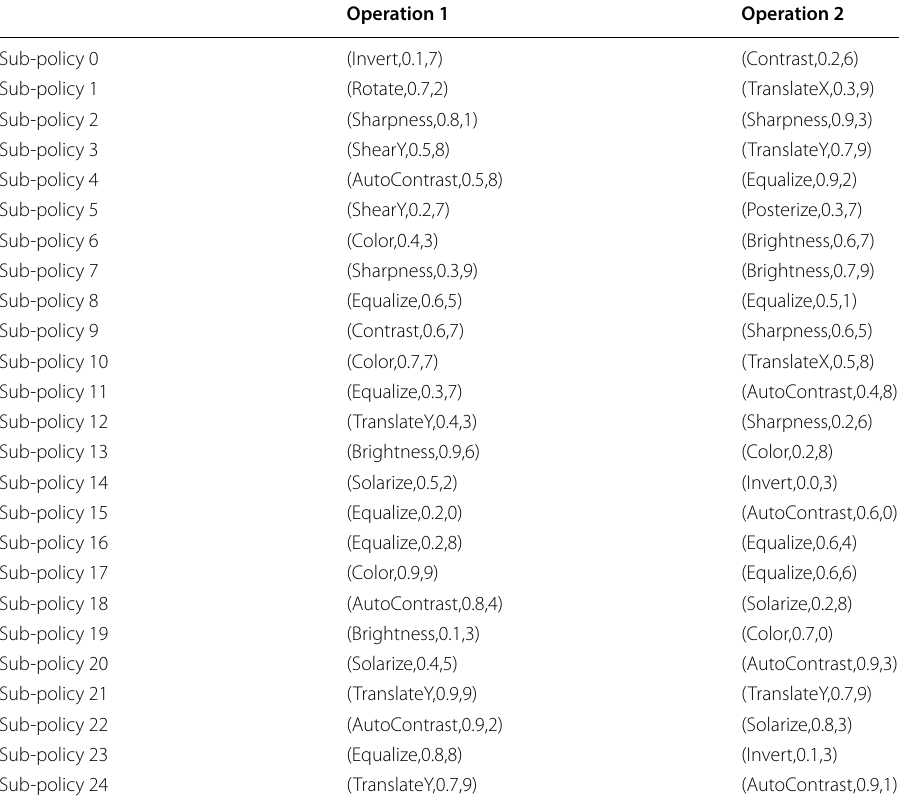
Table 8 AutoAugment augmentation policy found on the reduced CIFAR-10 dataset [38] Operation 1